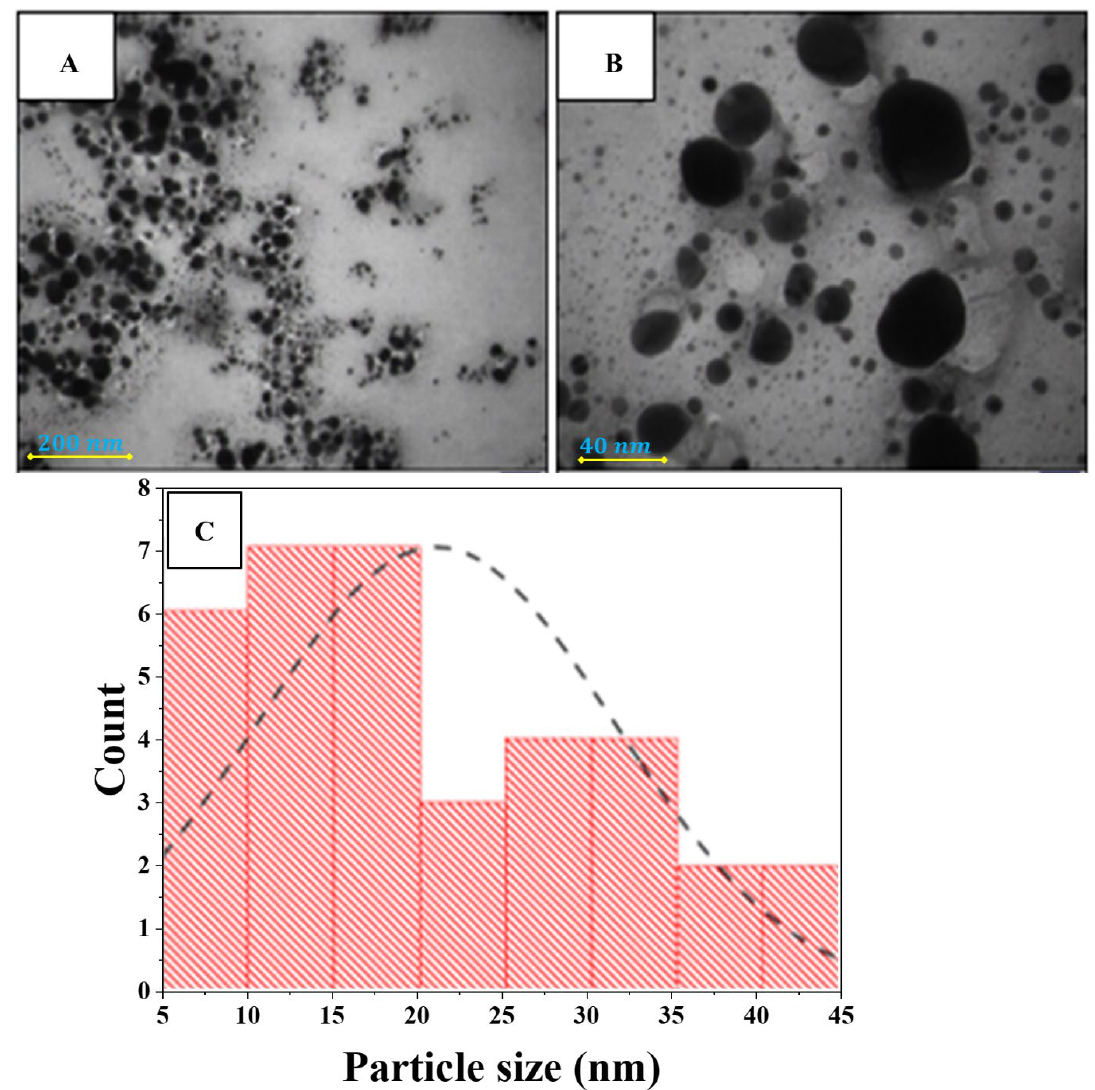
Figure 4. TEM images of Se NPs synthesized at ( A ) 200 nm magnification, ( B ) 40 nm magnification and ( C ) the histogram size distribution using Withania Somnifera extract.